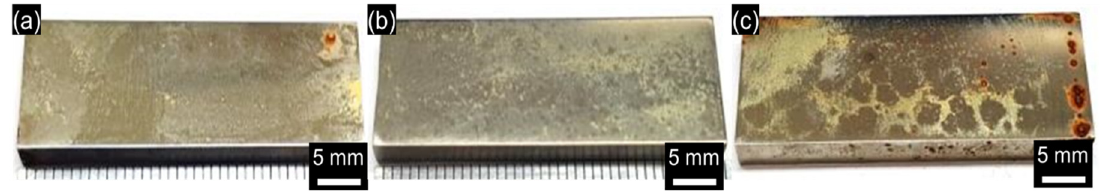
Figure 6. Corrosion morphologies of ( a ) B019, ( b ) B078, and ( c ) B176 alloys after immersion tests in a 0.6 M NaCl solution at 20 ± 1 °C for 35 days.